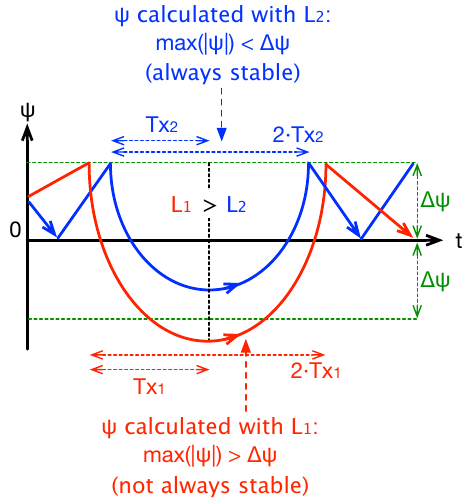
Figure 4. Detailed waveform of Ψ when v in ≈ 0 for different L